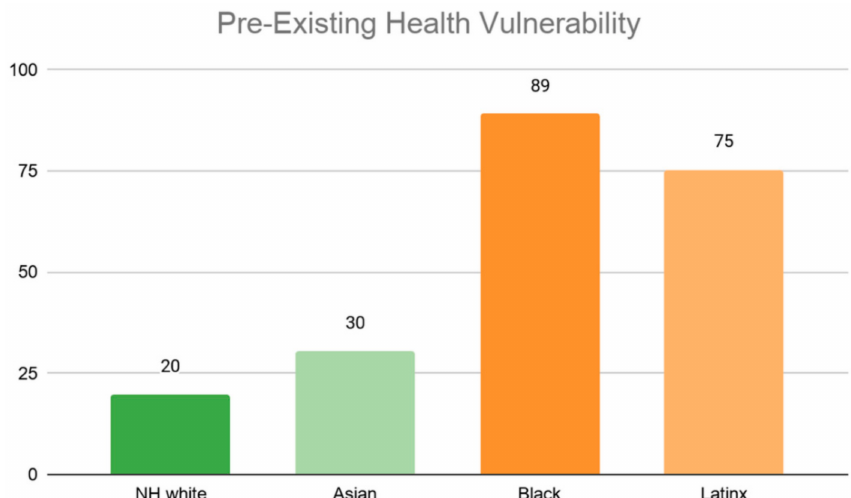
Figure 11. Average pre-existing health vulnerability index by Los Angeles County neighborhood’s racial majority.